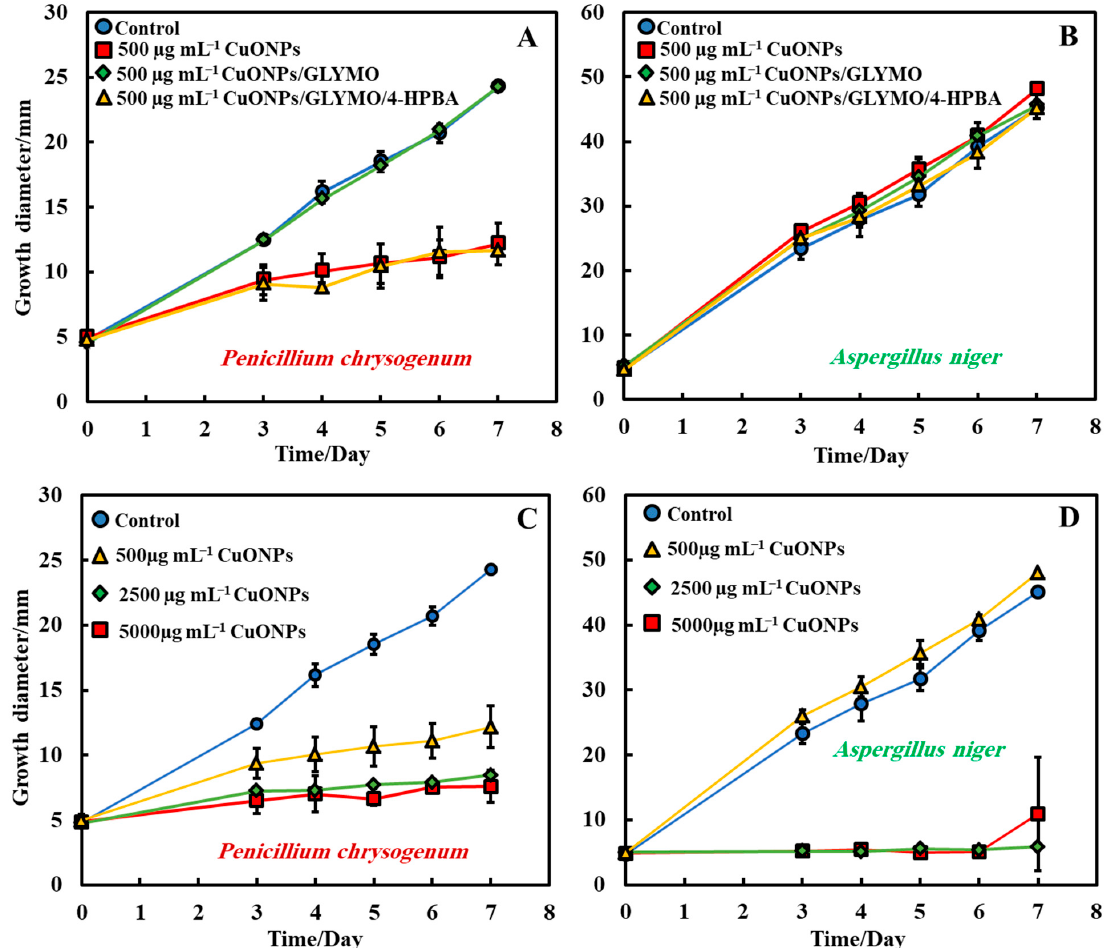
Figure 7. Growth diameter of a circular spot of ( A ) P. chrysogenum and ( B ) A. niger as a function of time to compare the antimould impact of the nanoparticles applied by using Method 3. Comparison of the growth diameter of a circular spot of ( C ) P. chrysogenum and ( D ) A. niger at different concentrations of the bare CuONPs. The solid lines are guides to the eye.